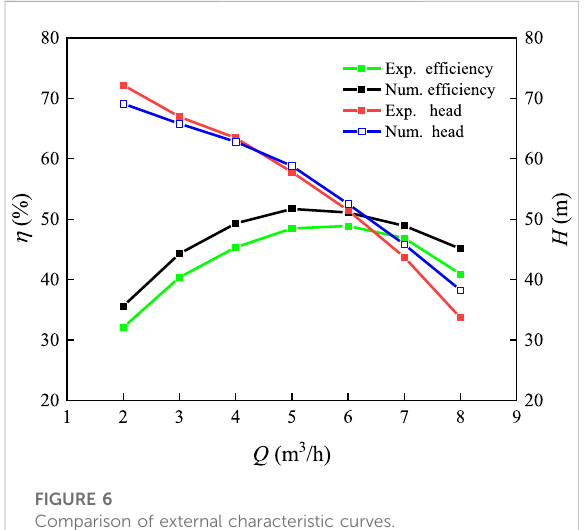
FIGURE 6 Comparison of external characteristic